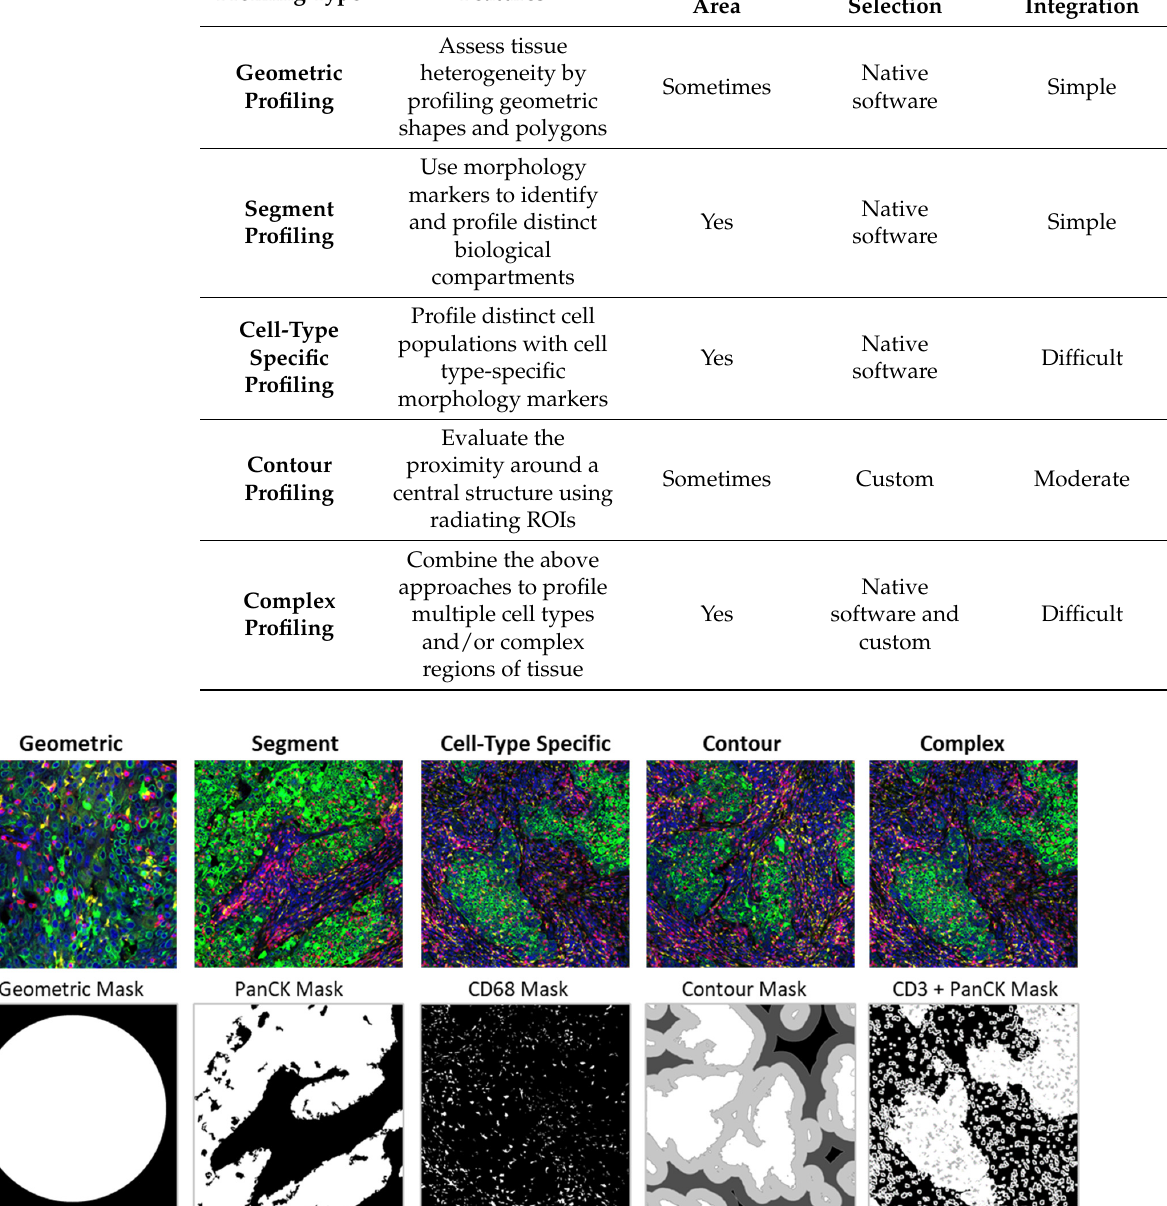
Figure 4. Representative images of AOI segmentation strategies in breast cancer tissues. The IF image was collected with the following morphology markers: PanCK (green), CD3 (red), CD68 (yellow) and DNA (blue). The mask image shows the captured AOI in white for geometric, segment, cell-type specific, contour and complex (PanCK+ tumor segment, CD3 cell-specific segment in the PanCK- stroma, CD3 cell-specific segment in the PanCK+ tumor and everything else) masking. For contour and complex masking, 4 separate masks are shown in grayscale.